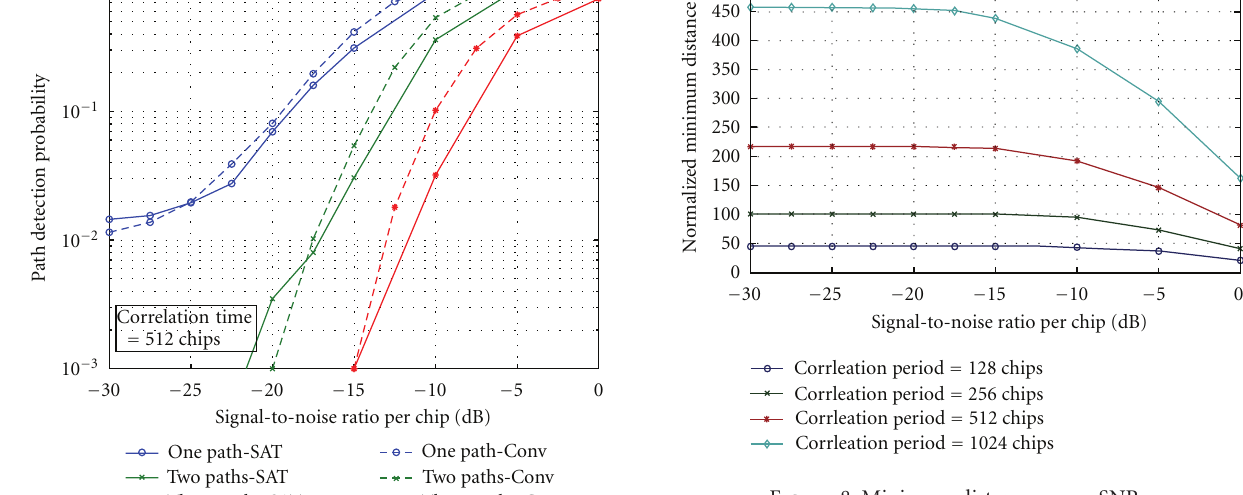
Figure 8: Minimum distance versus